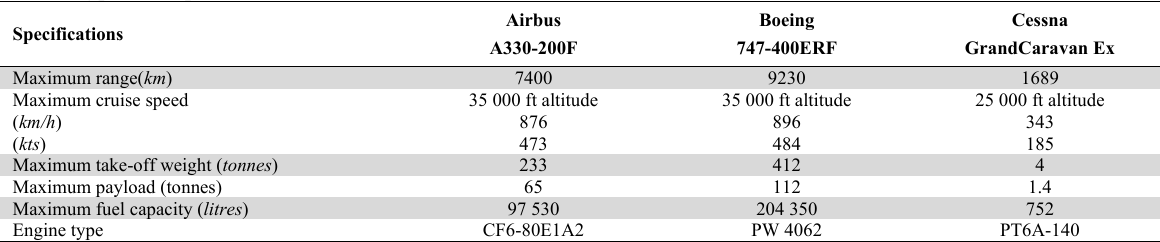
Aircraft types and specifications.